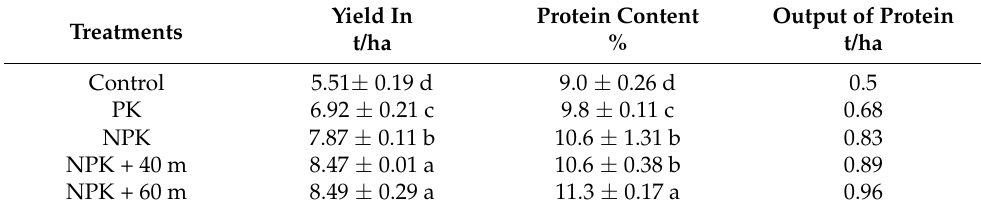
Table 5. Influence of mineral and organic fertilizers on the yield and protein content. Yield Treatments